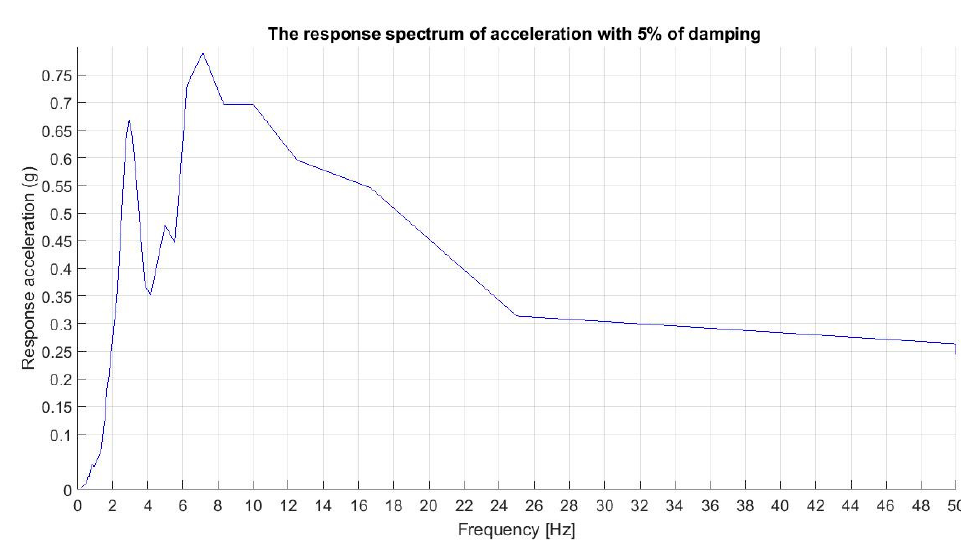
Figure 3. The response spectrum of acceleration.